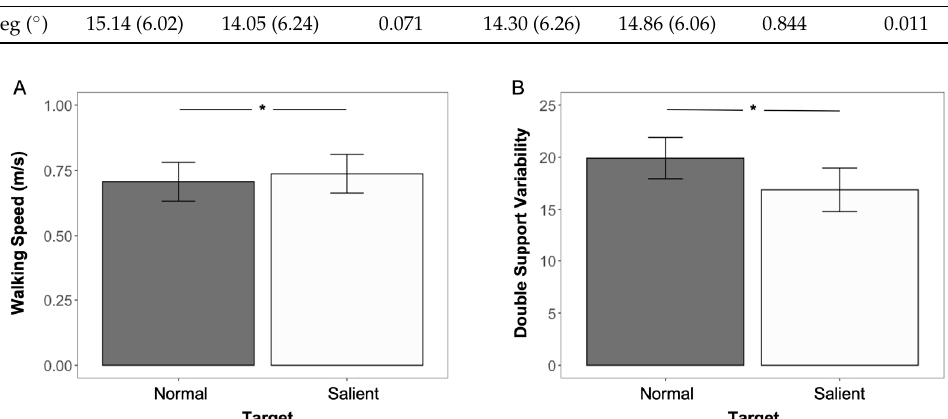
Figure 5. Comparison of spatiotemporal variables under two target conditions: significant difference in ( A ) walking speed and ( B ) double support variability between normal and salient conditions. The asterisk symbol (*) was used to indicate a significant difference with an alpha level of 0.05.